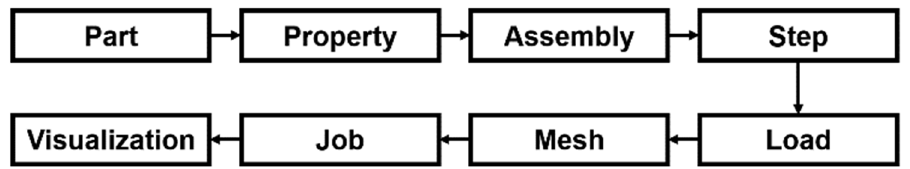
Figure 4. Finite element analysis flowchart on Abaqus.